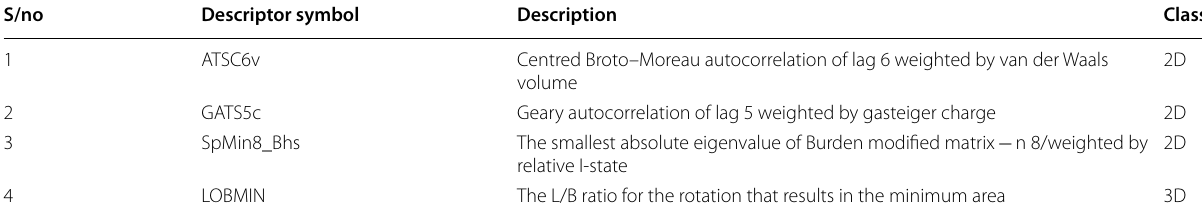
Fig. 3 The plot of standardized residuals against the leverage values (William’s plot) Table 4 Selected descriptors used in the QSAR model